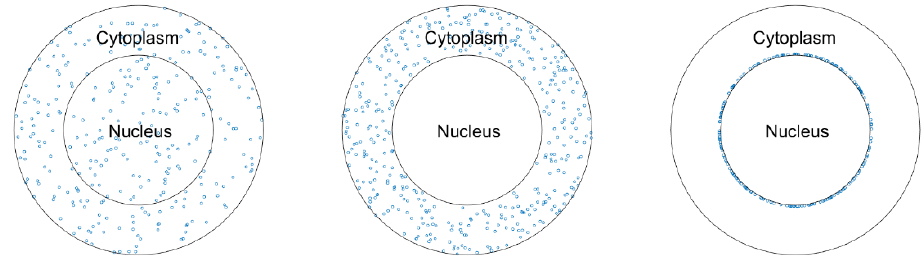
Figure 1. Three scenarios of NP distribution in the cell.